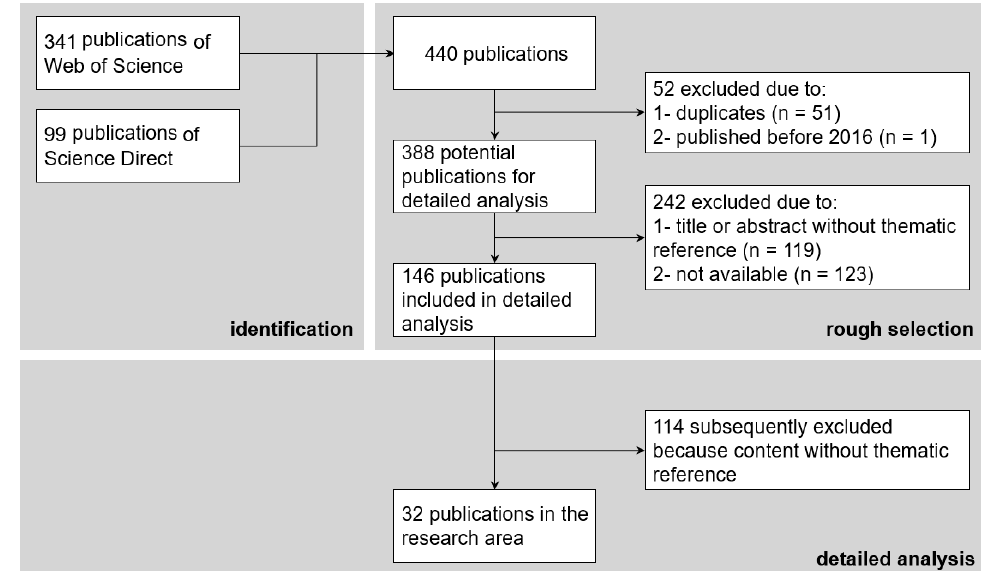
Figure 2. The literature filtering process [23] (p. 3) (greatly